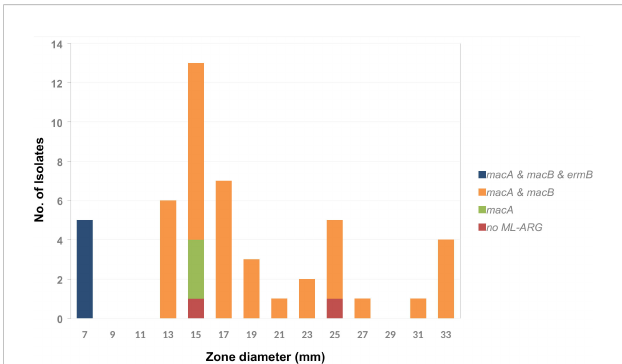
FIGURE 6 Frequency distribution of the macrolide resistance associated genes macA , macB , and ermB by erythromycin inhibition zone diameter within the tested A. butzleri isolates. The gene tolC occurs in 100% of the isolates of the tested collection and is therefore not included in the diagram.